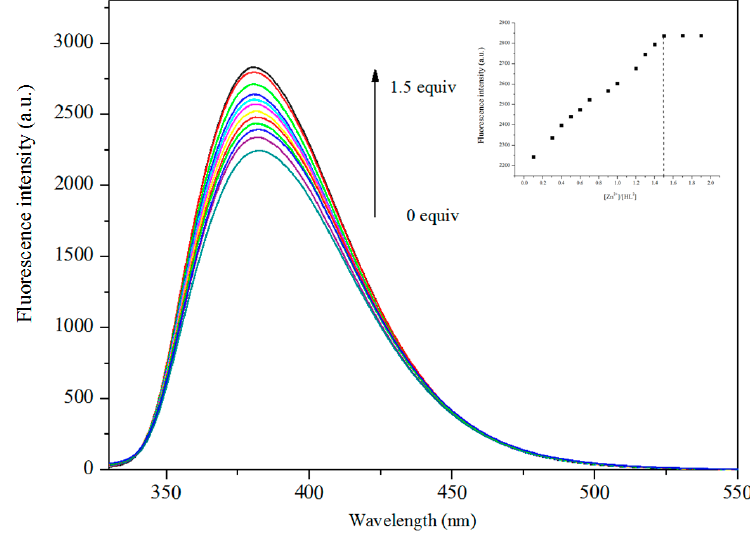
Figure 9. Absorption spectra of HL 2 in DMF solutions upon the addition of Zn 2+ . Inset: The absorbance at 380 nm varied as an interaction of [Zn 2+ ]/[HL 2 ].